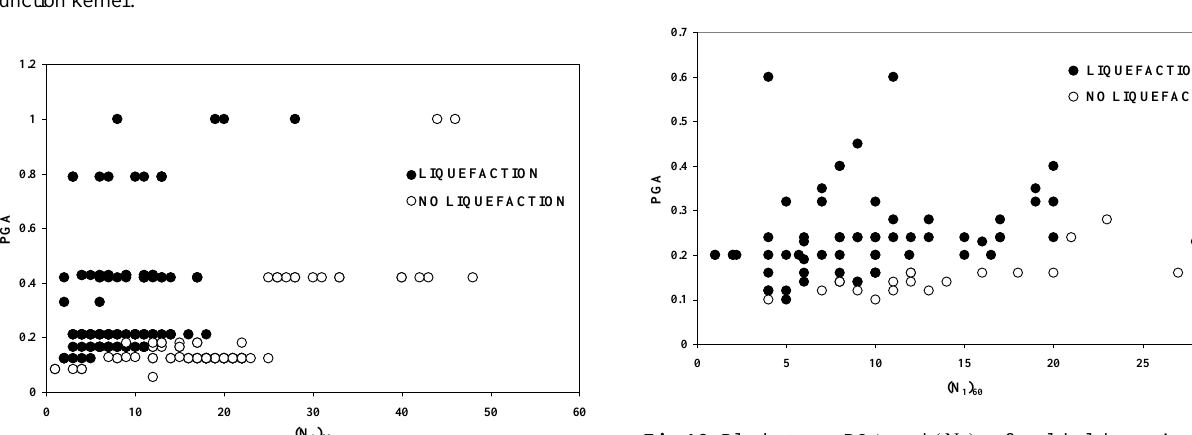
Figure 15. Plot between PGA and (N 1 ) 60 for MODEL II using radial basis function for testing dataset.